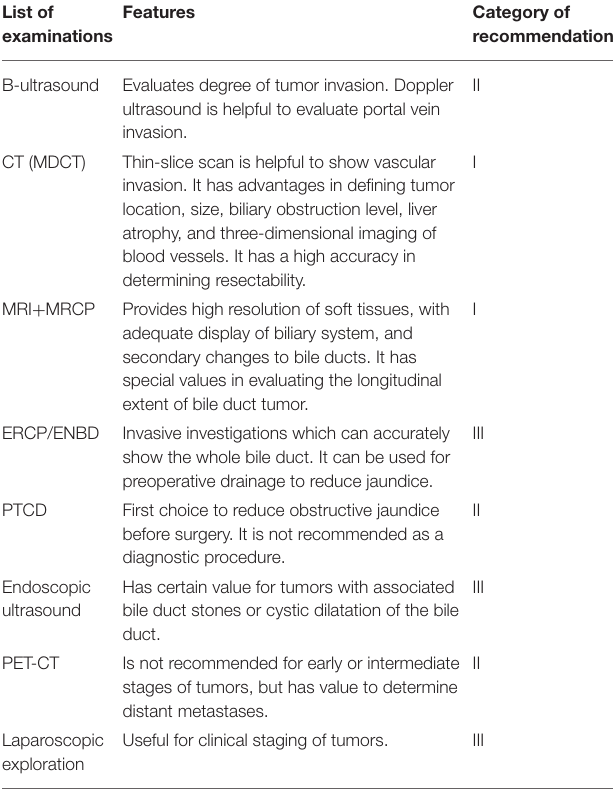
TABLE 3 | List of recommending preoperative examinations for hilar cholangiocarcinoma. List of Features examinations